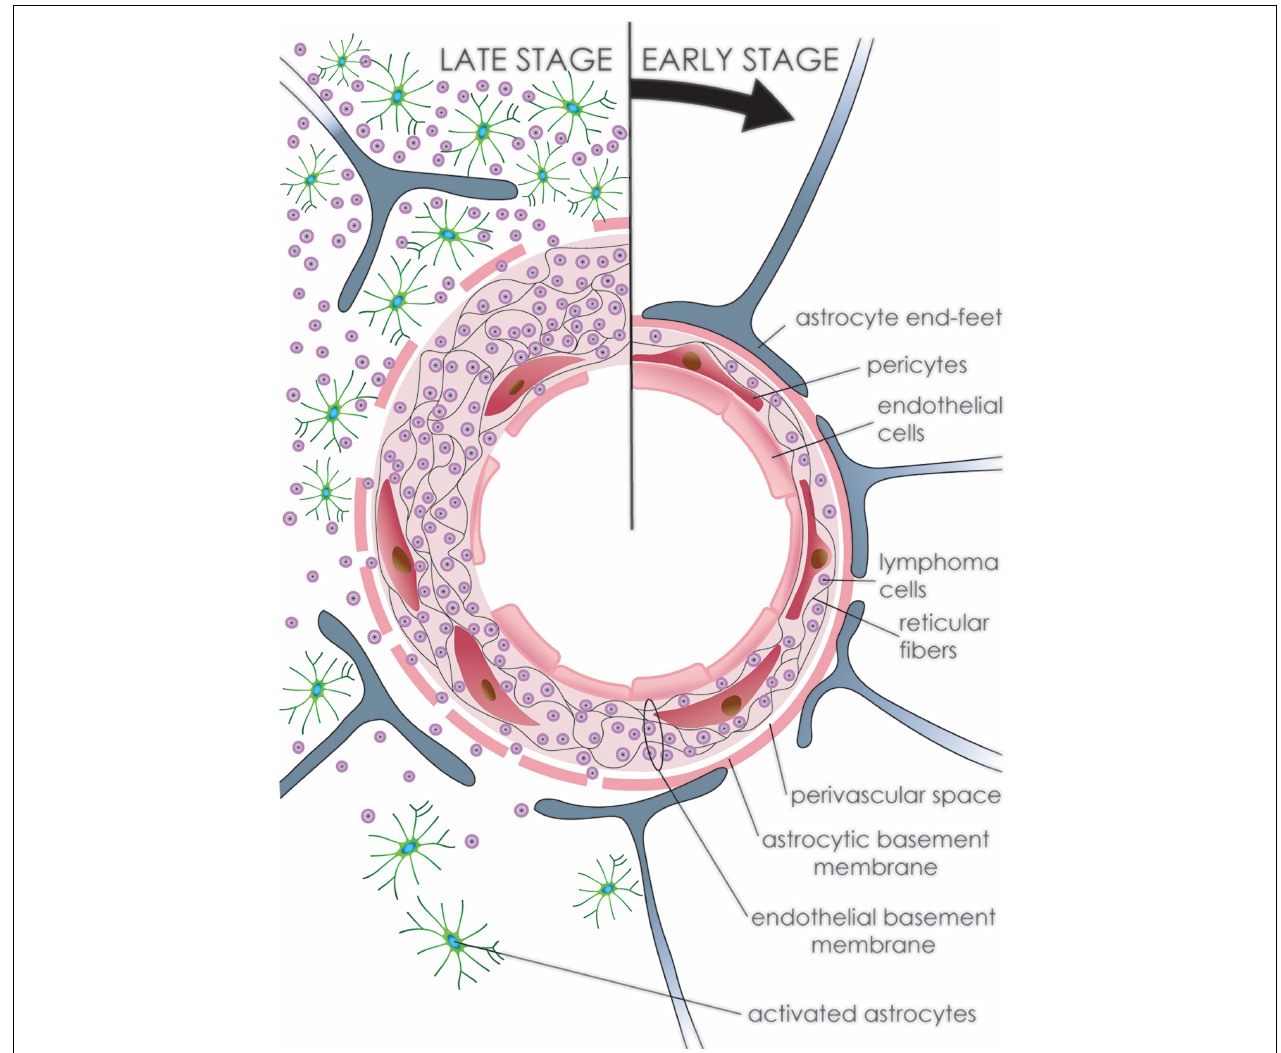
FIGURE 5 | Development of primary CNS lymphoma. Progression of PCNSL (clockwise from top). Initially, neoplastic lymphoid cells accumulate within the vascular wall of arteries and venules fragmenting the reticular fiber network. The outer vascular layer with the glial end-feet maintains an impermeable barrier preventing tumor cells from infiltrating the brain tissue. Later, tumor cells fragment the outer layer and infiltrate brain tissue, where multiple reactive astrocytes can be detected. Endothelial cells undergo regressive as well as reparative changes throughout, leading to disruption of the endothelial